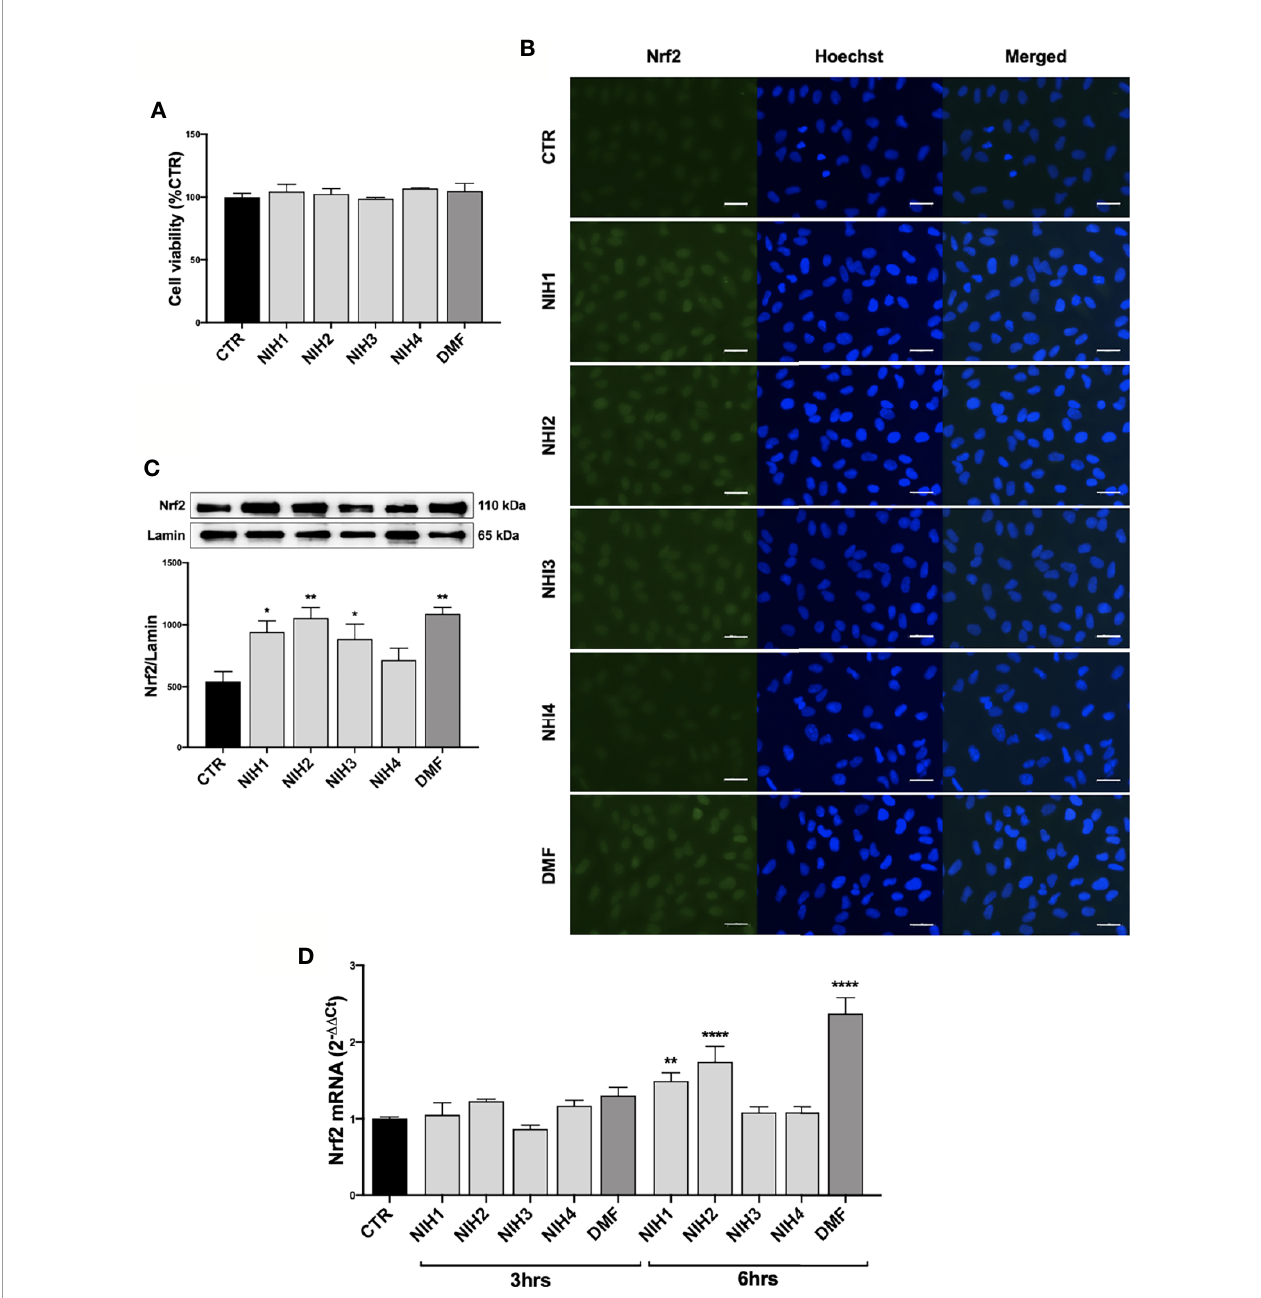
FIGURE 3 | Pharmacological activation of Nrf2 protein by NIH in ARPE-19 cells. (A) Tolerability of NIH in ARPE-19 cells. ARPE-19 cells were treated for 48 h with solvent (DMSO, CTR), NIH1, NIH2, NIH3 and NIH4 [5 m M], or DMF [10 m M], and their viability was assessed by MTT assay. Results are expressed as mean of percentages ± SEM (CTR: 100%); Dunnett ’ s multiple comparisons test; no statistical differences versus CTR; n = 3 – 5. (B – C) Evaluation of NIH-induced Nrf2 nuclear translocation. ARPE-19 cells were treated for 3 h with either solvent (DMSO, CTR), NIH1, NIH2, NIH3, NIH4 [5 m M], or DMF [10 m M]. (B) Immunocytochemistry for Nrf2 protein localization was performed by using a green fl uorescent-conjugated secondary antibody. Nuclei (blue) were stained by Hoechst. Scale bar: 20 m m. (C) Nuclear fraction was isolated and examined by Western blot using an antibody against Nrf2. Lamin A content was used as a loading control to normalize the data. Results are expressed as means of Nrf2/Lamin A (ratio × 1000) ± SEM. Dunnett ’ s multiple comparisons test; *p<0.05 and **p<0.01 versus CTR; n=5. (D) Study of Nrf2 mRNA expression following NIH treatment. Total Nrf 2 mRNA levels were measured by RT-qPCR in ARPE-19 cells exposed to either solvent (DMSO, CTR), NIH1, NIH2, NIH3, NIH4 [5 m M], or DMF [10 m M] for 3 and 6 h. GAPDH mRNA content was used as a housekeeping to normalize the data. Results are expressed as means of 2 − DD Ct ± SEM. Dunnett ’ s multiple comparisons test; **p <0.01 and ****p <0.0001 versus CTR; n =